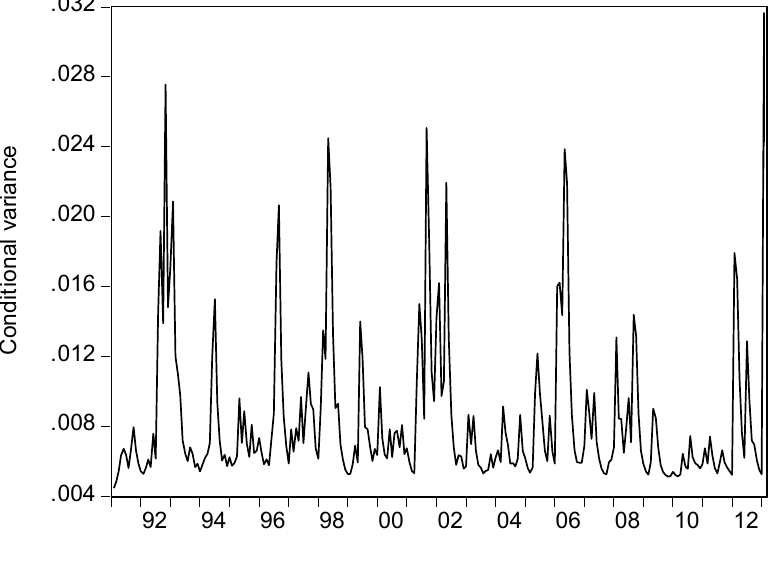
Figure 2. Conditional variance of the unpredictable component of maize price in Malawi by month (January 1991-March